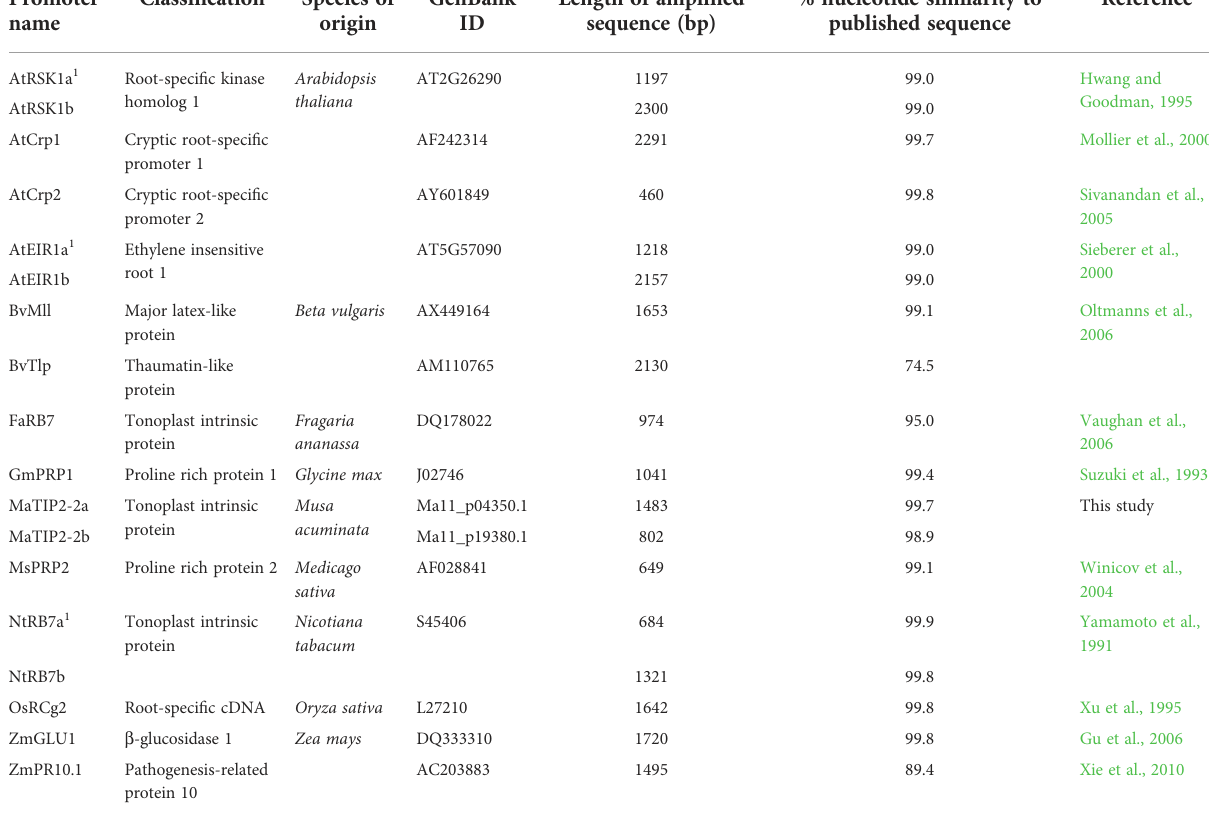
TABLE 1 List of promoter sequences used for analysis in tobacco and